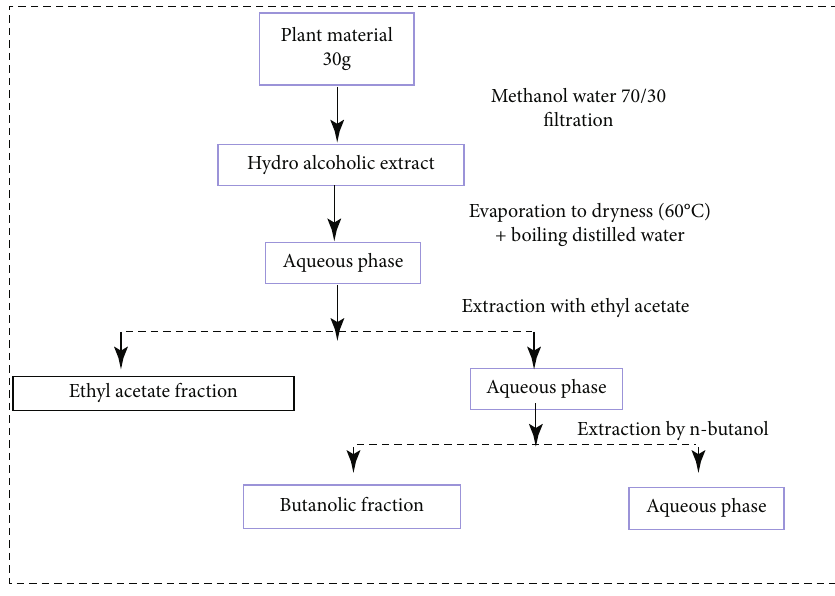
Figure 1: Stages of extraction and fractionation of phenolic